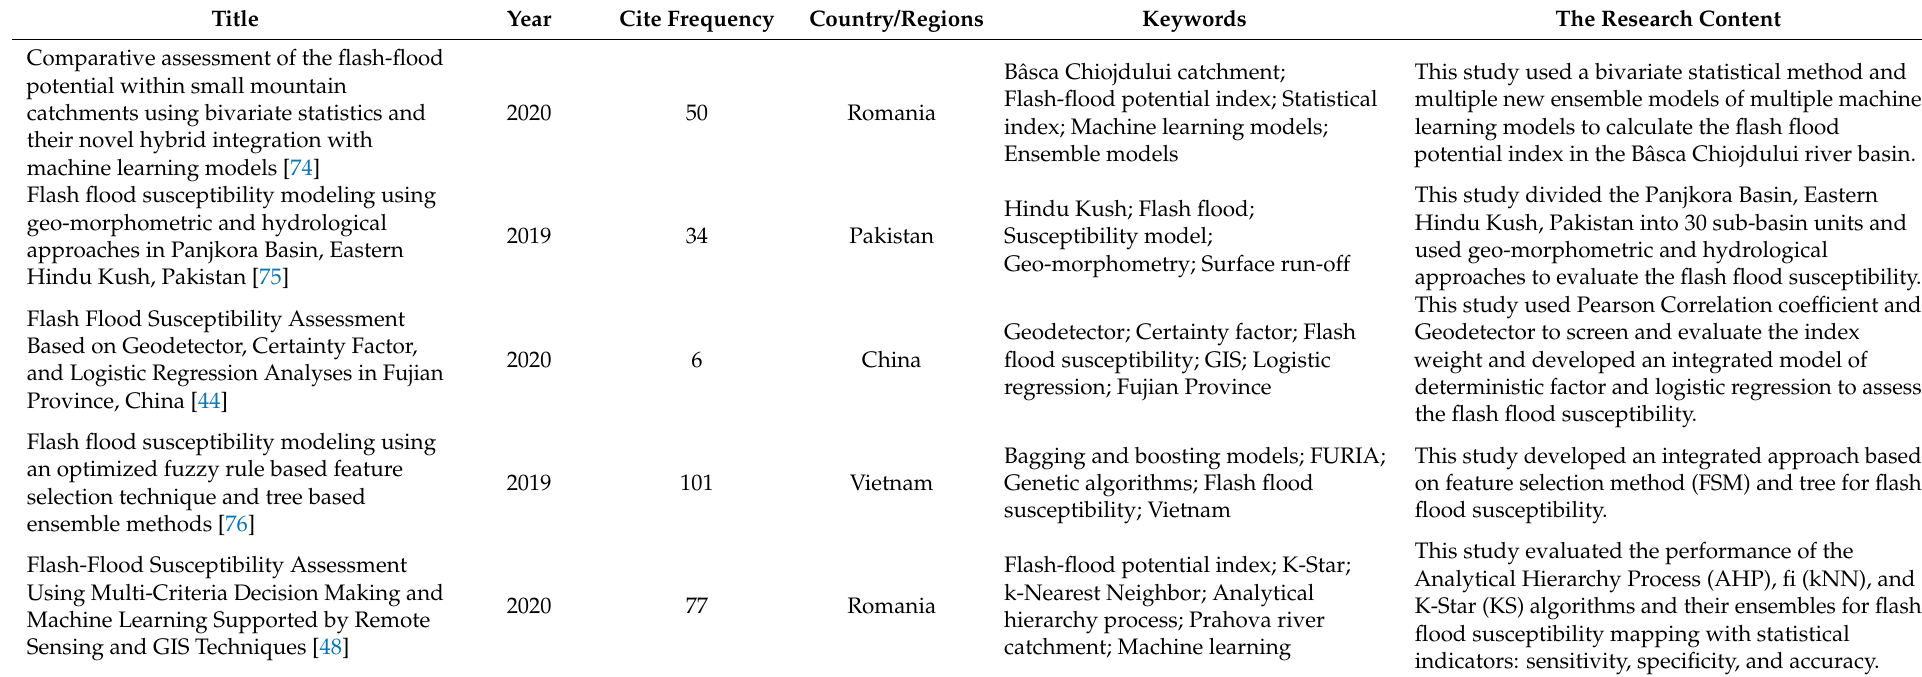
Table 2. Characteristic analysis of representative